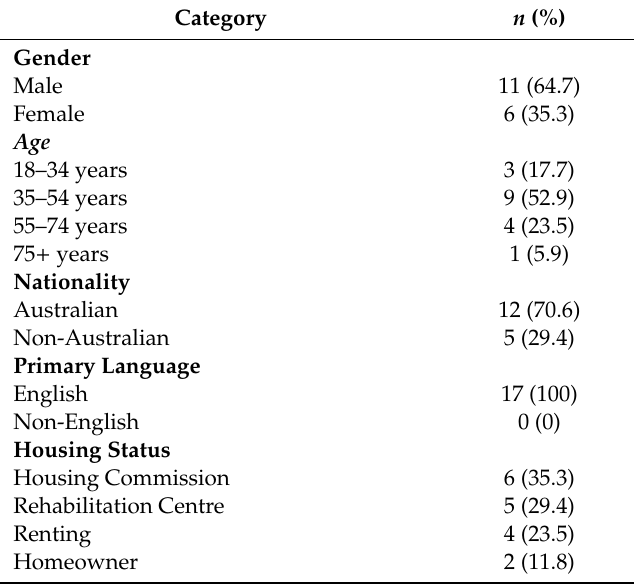
Table 6. Demographics of NEST interview participants ( n =